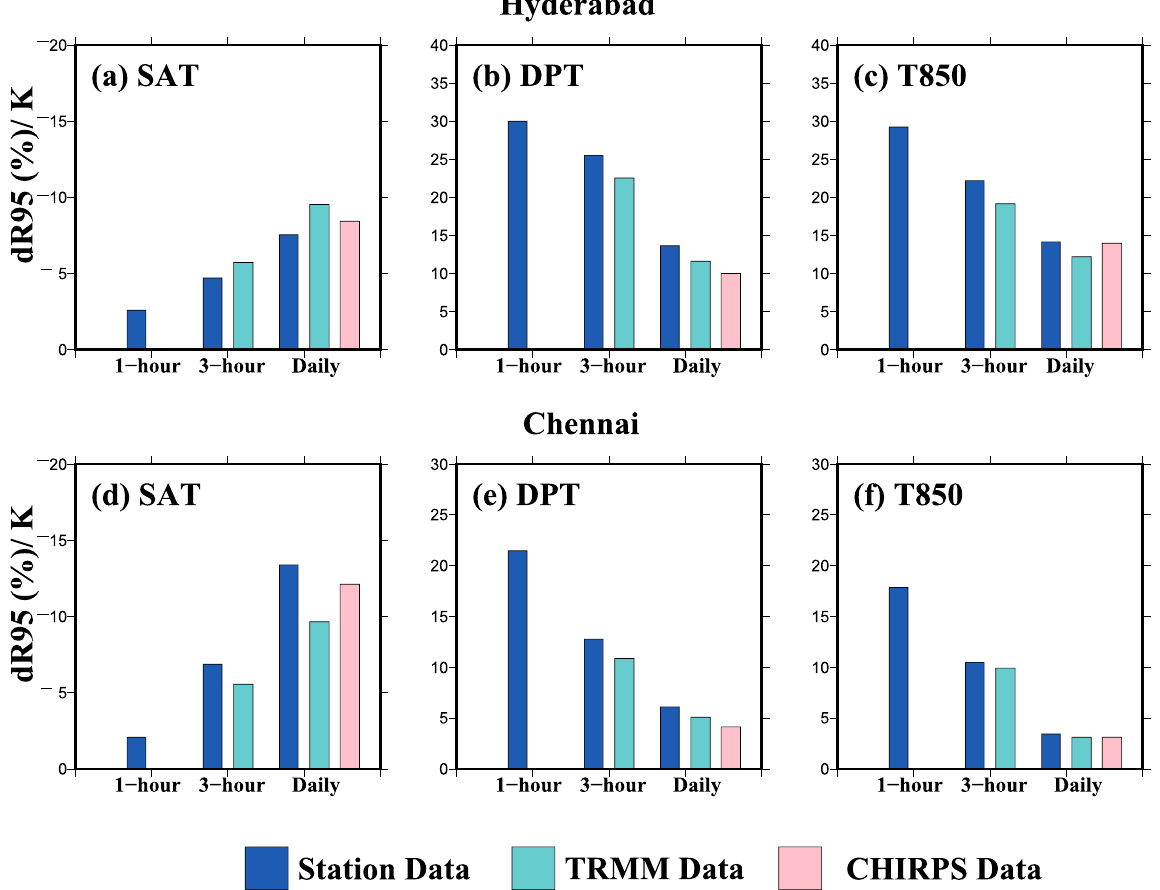
Figure 4. ( a – c ) Regression slopes (dR95/K, %) obtained using rainfall from station (blue; for 1979–2013), TRMM (cyan; for 1998–2013) and CHIRPS (pink; for 1979–2013) data with ( a ) SAT, ( b ) DPT, and ( c ) T850, respectively for 1-hour, 3-hour and daily durations for Hyderabad using quantile regression (QR) at the 95th percentile, ( d – f ) same as ( a – c ) but for Chennai for period 2008–2013 for all the datasets. The figure was developed using the Generic Mapping Tools (GMT,